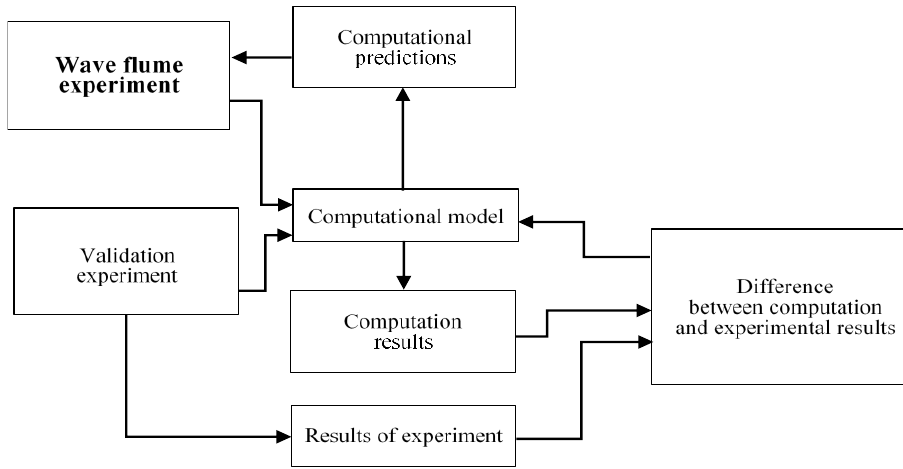
Figure 15. Flow chart of validation of the computational model against experimental